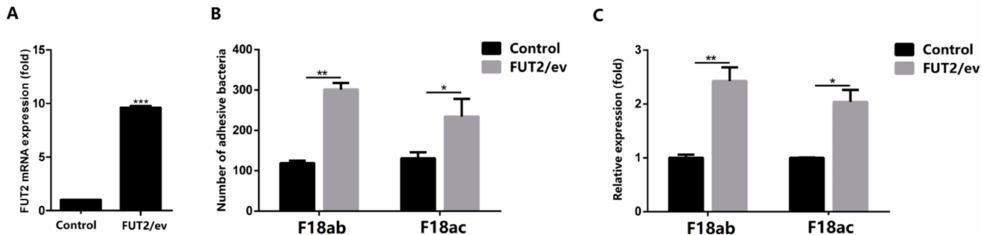
Figure 6. The effect of FUT2 gene overexpression on the adhesion of E. coli F18 to IPEC-J2 cells. ( A ) Overexpression efficiency evaluation by detecting mRNA expression levels of FUT2 in pcDNA3.1 (Control) cells and pcDNA3.1-FUT2 (FUT2/ev) cells, *** p < 0.001; ( B , C ) Adhesion of the F18 fimbria to IPEC-J2 cells analyzed by bacteria enumeration ( B ) and detection relative quantification ( C ), data are shown as mean ± SD, n = 3 biological replicates, * p < 0.05. ** p <